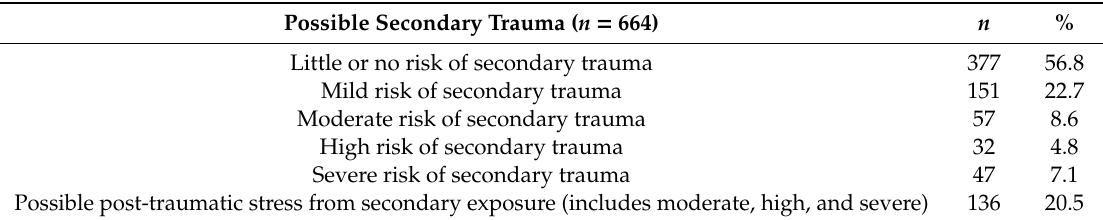
Table 1. Adapted secondary traumatic stress (STS) scale